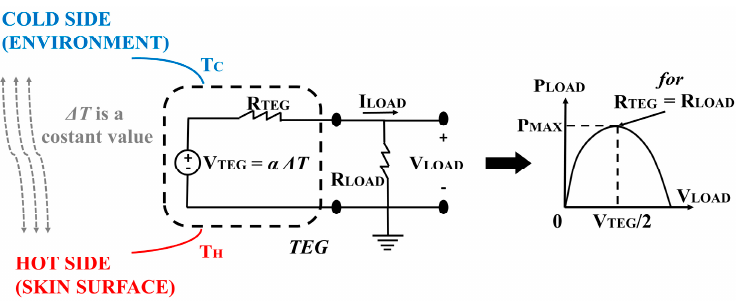
Figure 2. Electrical circuit for the measurements of power generated by the TEG, with the corresponding graph about the track of the power output while measuring the closed circuit voltage.